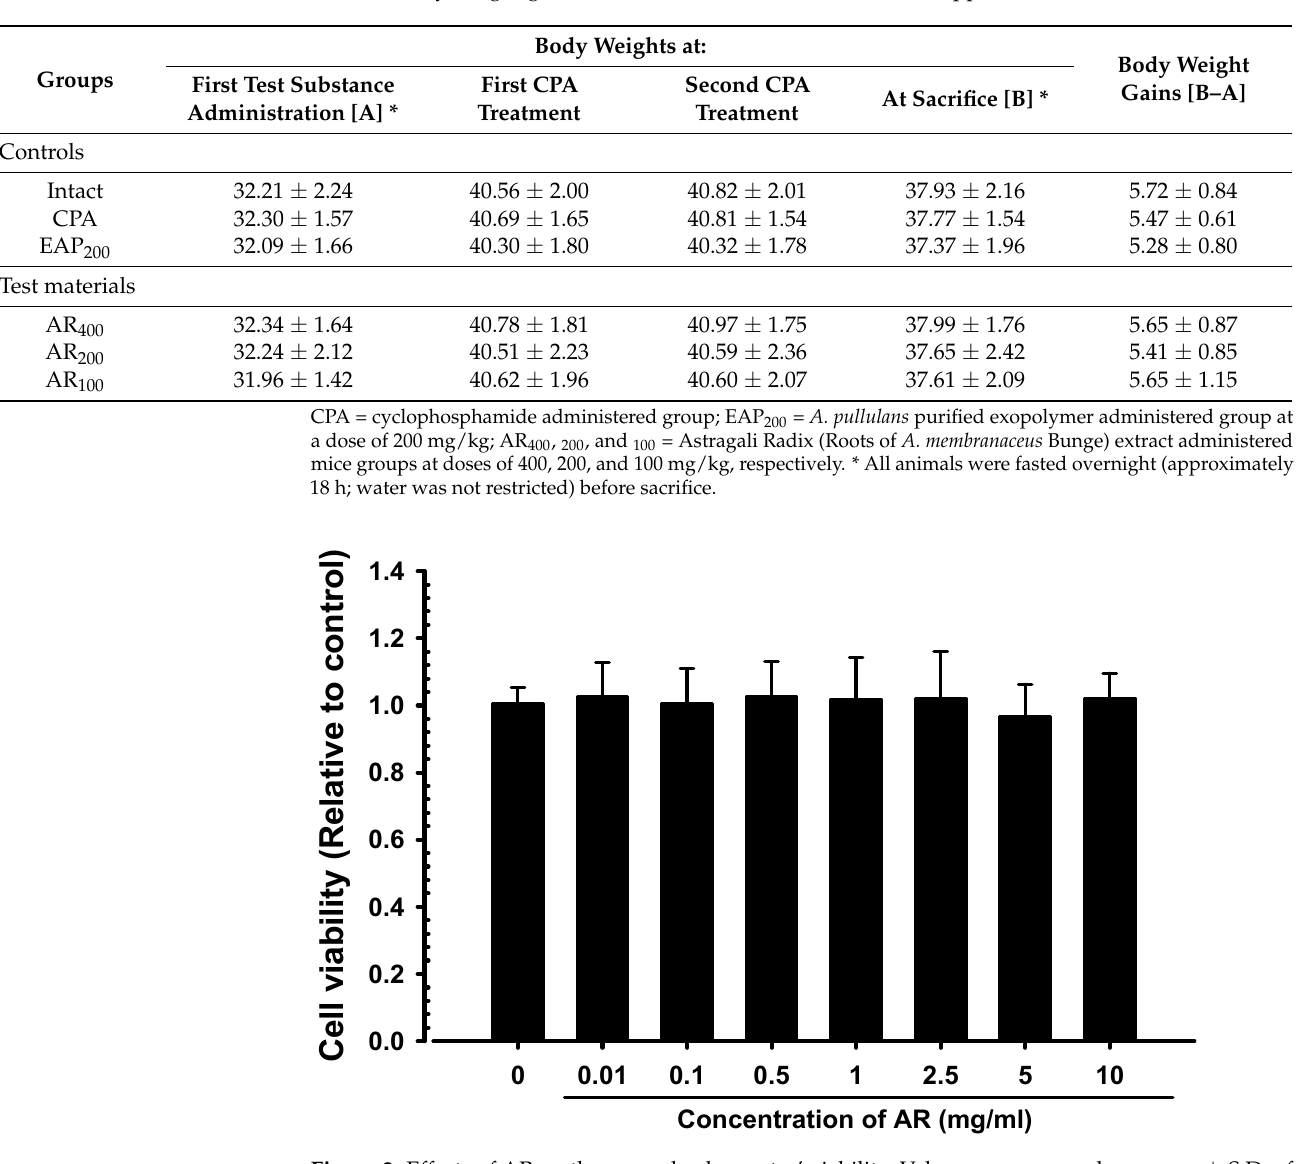
Table 1. Body weight gain in intact and CPA-induced immunosuppressed mice.